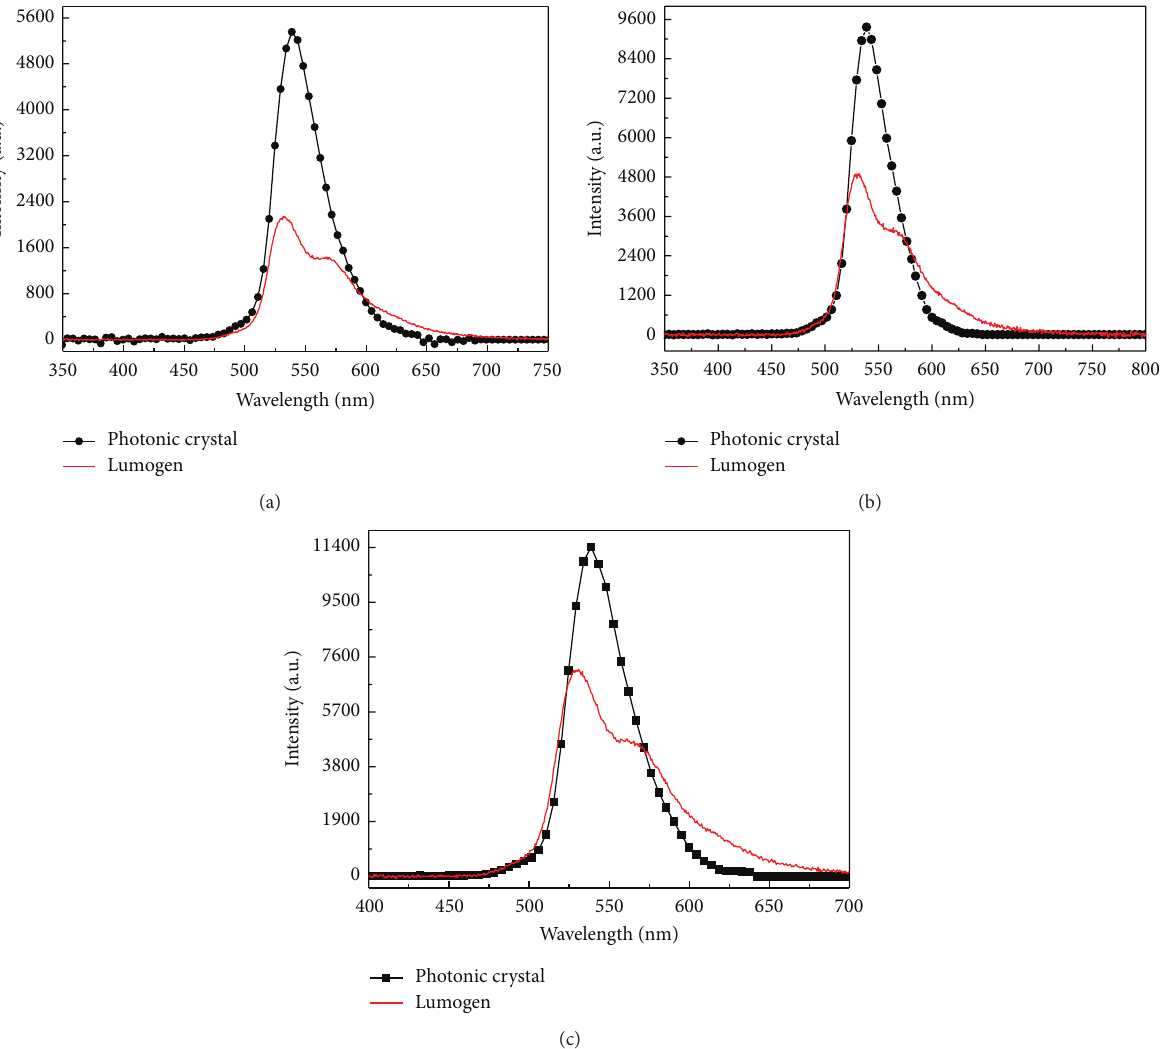
Figure 10: PL spectrum of one-dimensional photonic crystal excited at 250, 300, 330